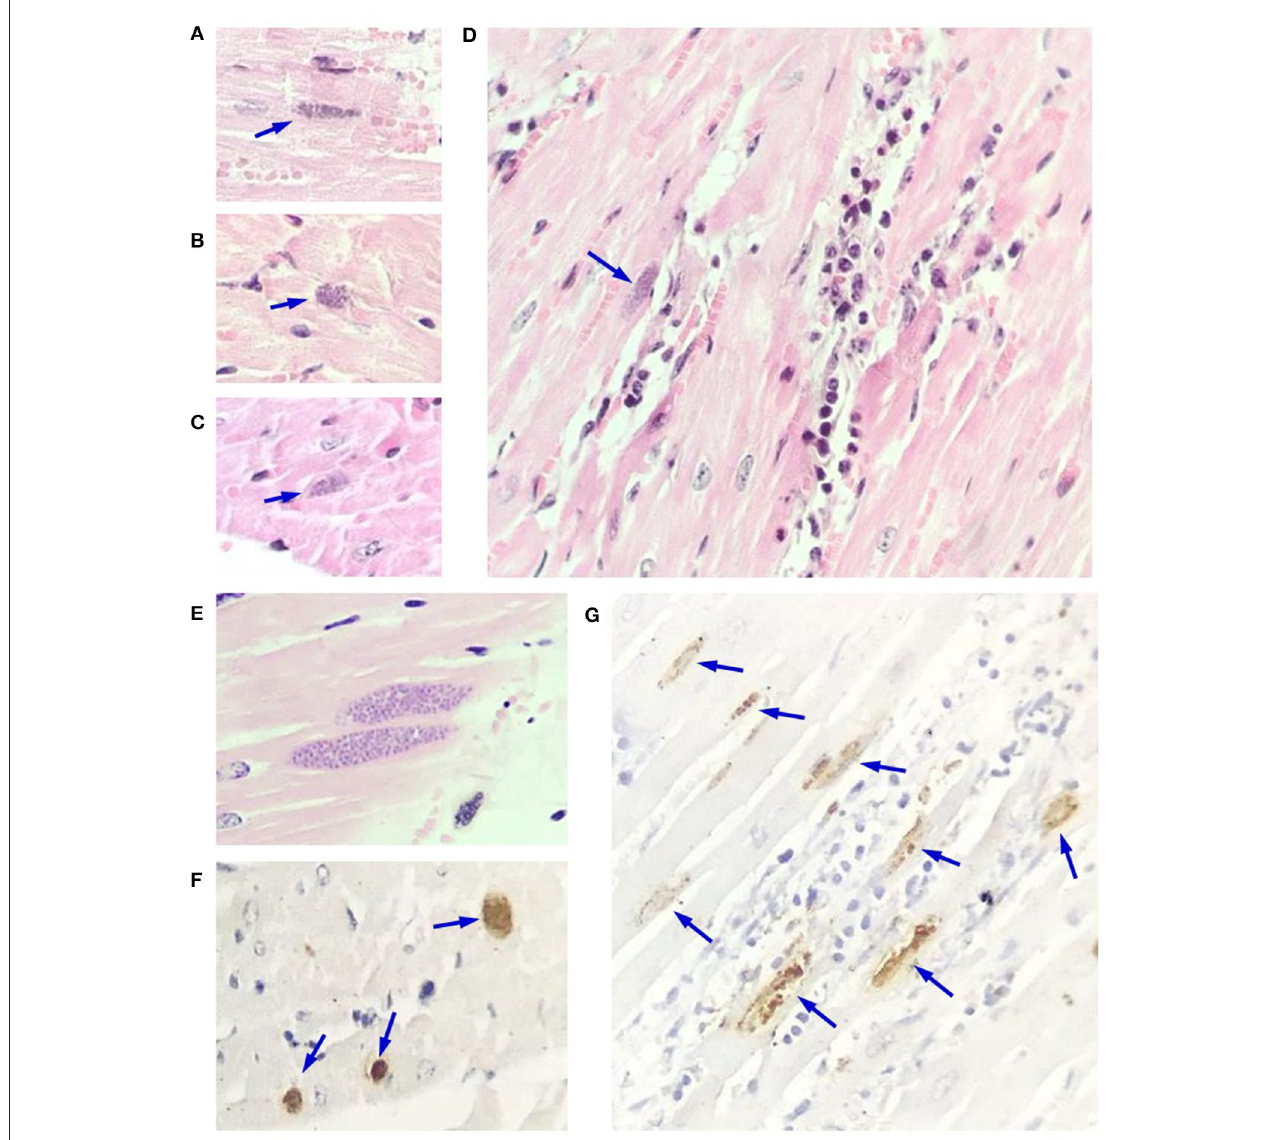
FIGURE 2 | Microscopic findings in myocardium of macropods. (A–C) Toxoplasma gondii tissue cysts (arrows) of different sizes in cardiac fibers. (D) Necrosis and degeneration of fibers, as well as a mixed inflammatory infiltrate with a tissue cyst (arrow) adjacent to the area of injury. (E) Myocardial section without alterations with two large tissue cysts. (F,G) Myocardial section showing abundant immunopositive tissue cysts with variable marked distribution, without (F) and with inflammatory infiltrate (G) . (A–E) : hematoxylin and eosin, 500x. (F,G) : Immunohistochemistry, streptavidin avidin peroxidase complex. (F,G) 350x and 480x, respectively.